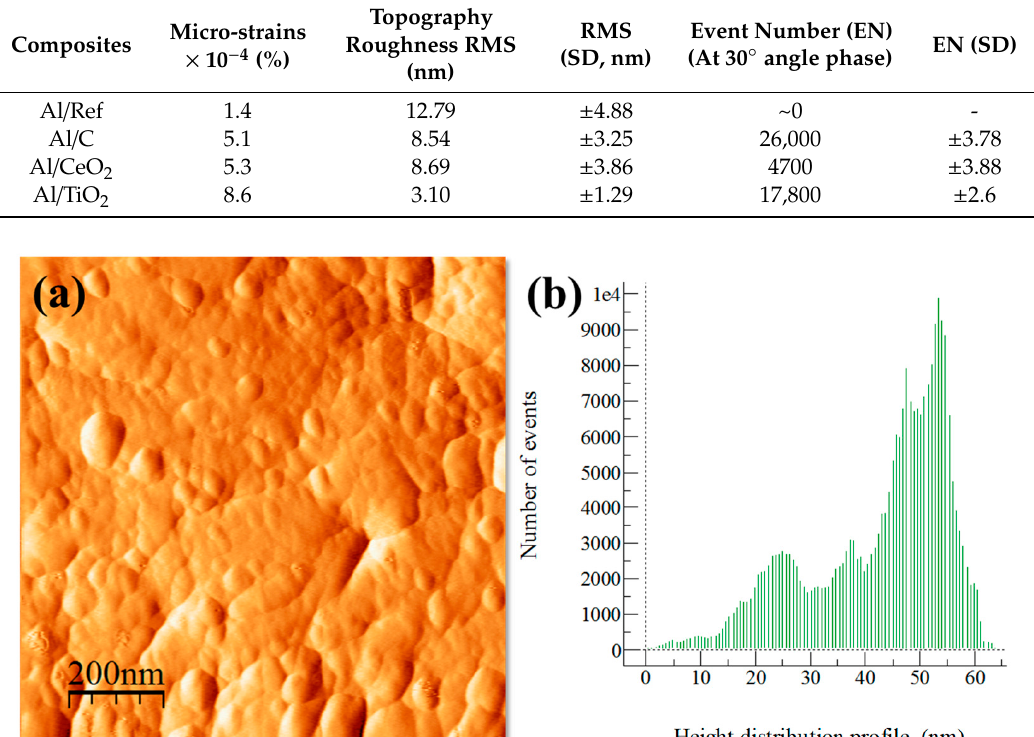
Figure 3. Al / Ref sample after the extrusion process: ( a ) AFM topography image and ( b ) height distribution profile of surface roughness. Table 3. Micro-strain, topography roughness (RMS), and event number (EN) and the correspondent standard deviation (SD) values.